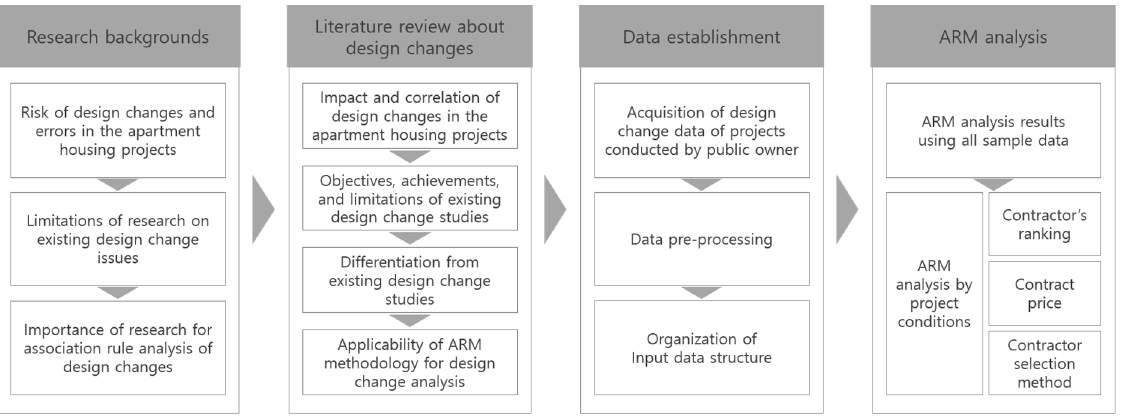
Figure 1. Research process.